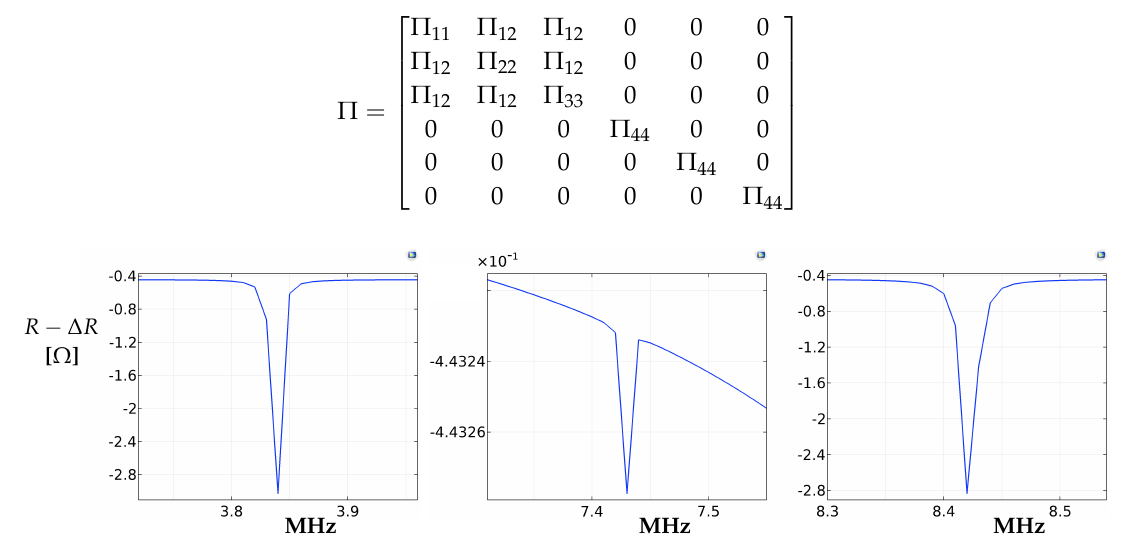
Figure A13. The first three resonant modes of the device that has no initial compression (see Table 1, column 3) and the corresponding resistance peaks. The resistance changes are represented by the expression R − ∆ R where R = 420,219.19 Ω is the resistance of the structure at rest and ∆ R is the stress dependent